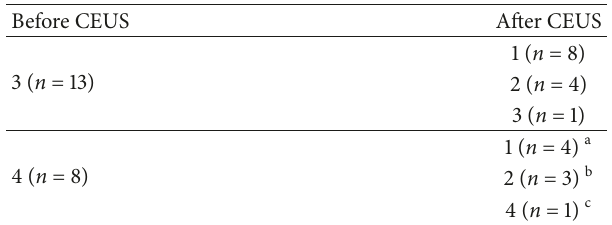
Table 2: Conspicuity score before and after CEUS in the 21 patients with fusion imaging-inconspicuous